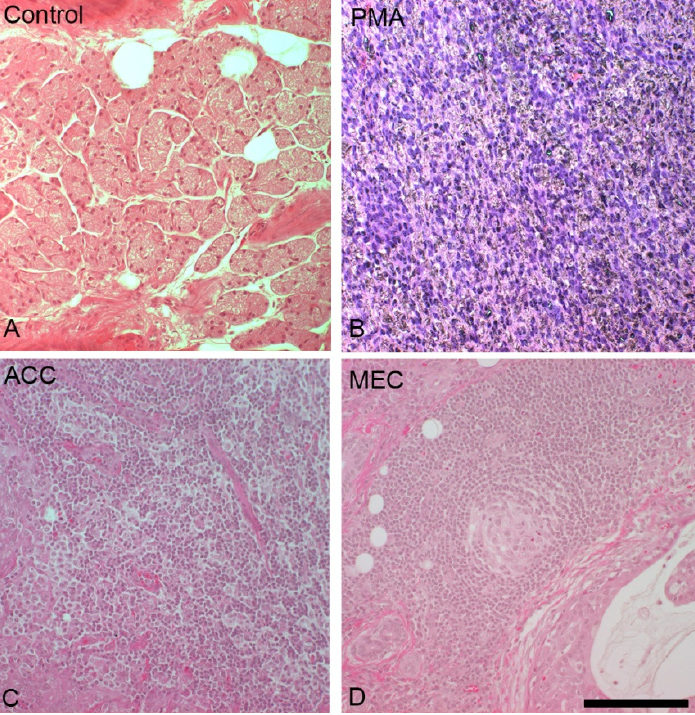
Figure 1. Comparison of the structural differences between control, pleomorphic adenoma (PMA), mucoepidermoid carcinoma (MEC), and acinar cell carcinoma (ACC) parotid gland tissue stained with HE staining. Control parotid tissue ( A ) is compared with PMA, which is composed of different cells of epithelial and mesenchymal lineage differentiations ( B ). ACC tumor cells resemble acinar cells in structure and pattern ( C ). MEC consists mostly of squamous epithelium and mucus-forming epithelium ( D ). Bars represent ( A – D ) 100 μ m. Table 4. Results of patient probes with mucoepidermoid carcinomas to various markers.